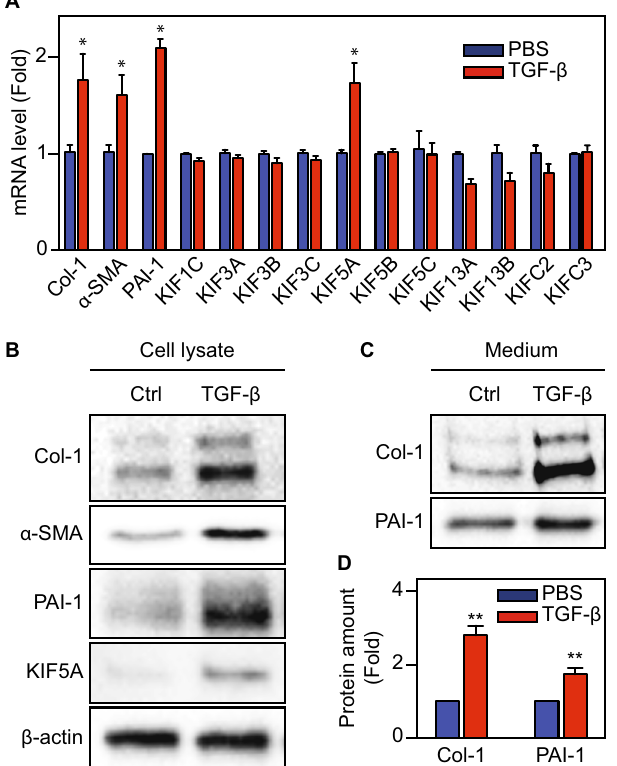
Figure 1. Upregulation of motor proteins during MesoMT. ( A ) mRNA level of motor proteins during MesoMT (n = 6). ( B , C ) Protein amount were investigated by western blotting in both cell lysate ( B ) and culture medium ( C ). Full-length blots were presented in Supplementary Figs S2 and S3. ( D ) Quantitative analysis using densitometry of western blotting of C (n = 3 for Col-1, n = 4 for PAI-1). * P < 0.05, ** P < 0.01 vs basal